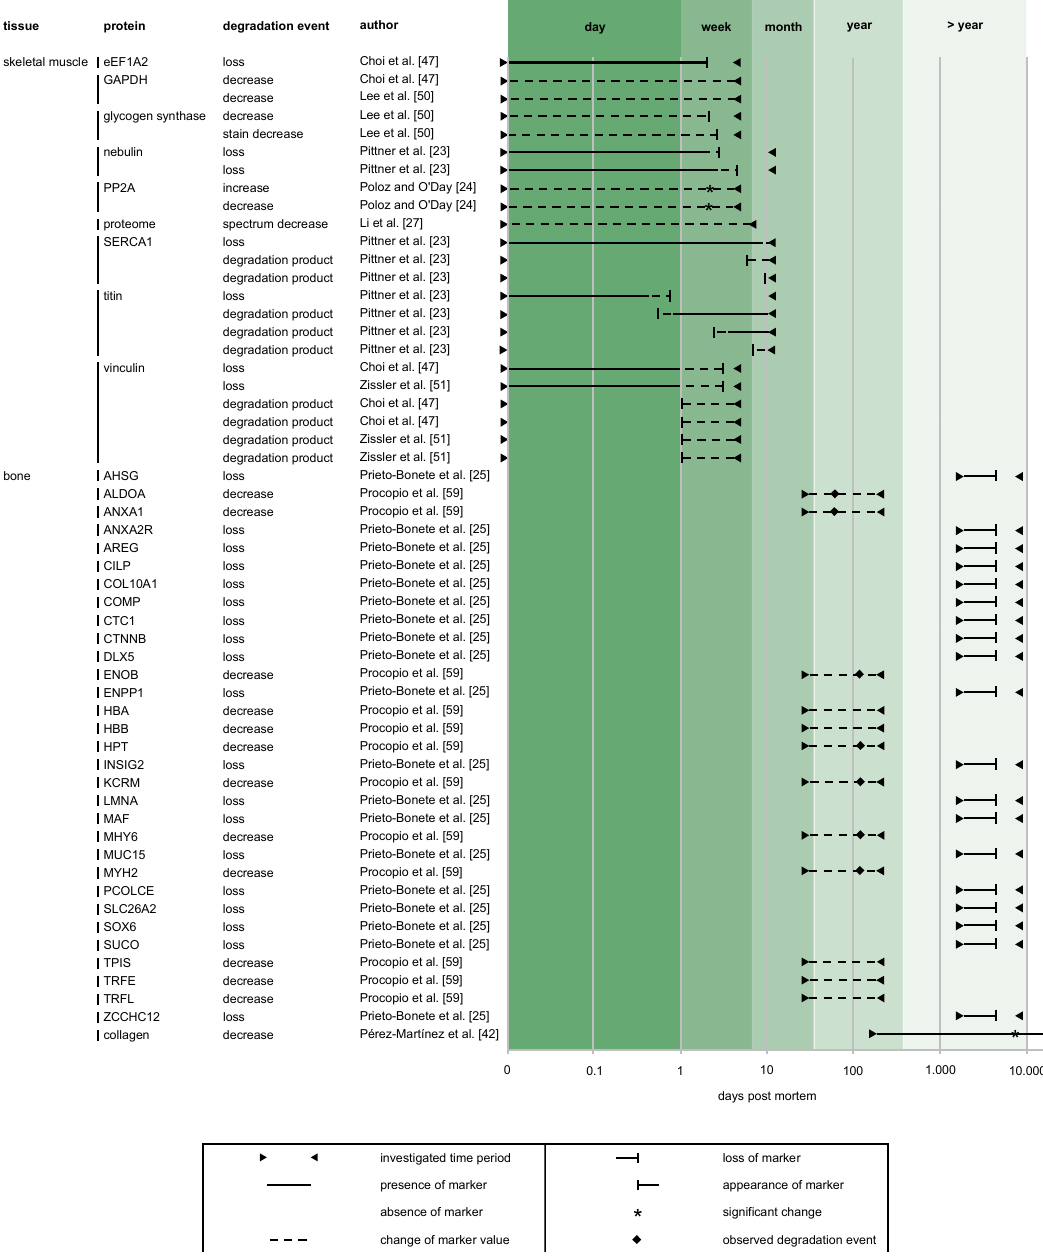
Figure 6. Summary of postmortem degradation events of proteins in various tissues over investigated PMI in logarithmic scale, demonstrating the applicability of tissues and proteins in respective postmortem time frames. The figure includes all proteins originating from studies assigned with a low and moderate risk of bias. Temporal references (day, week, month, year, >year) are indicated by different background colors.